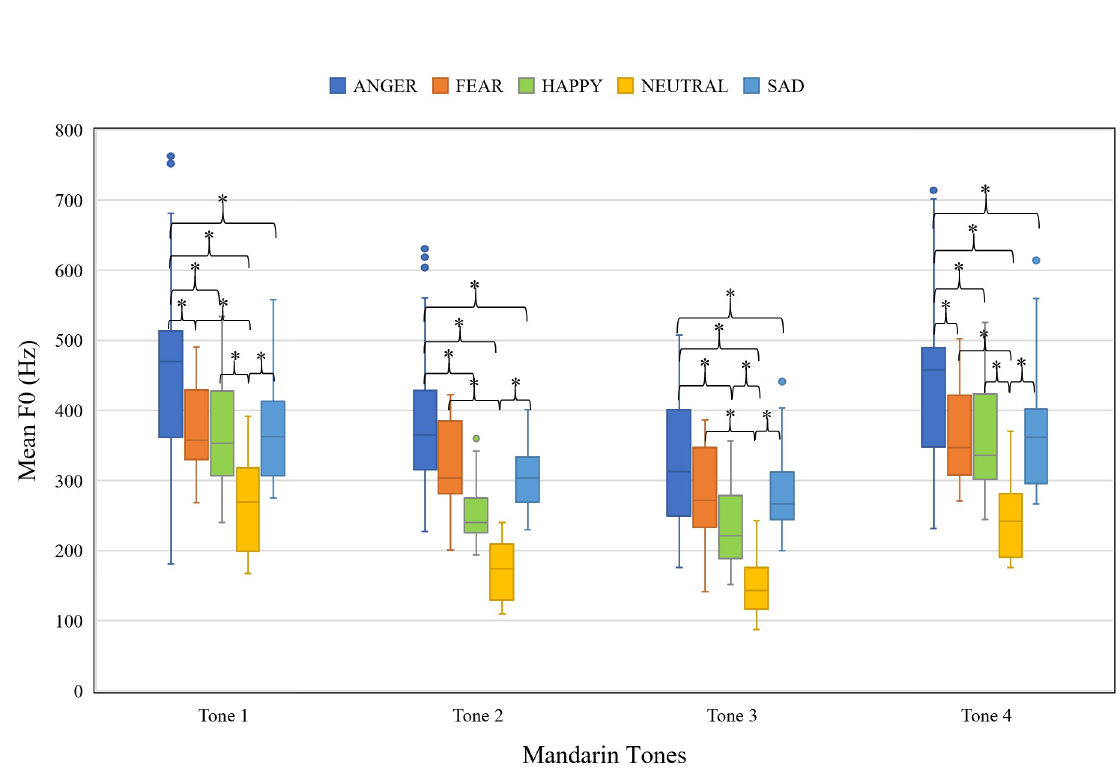
Fig 2. Boxplot showing the mean F0 of target syllables as a function of Mandarin tone and emotion. ( * p < .05).